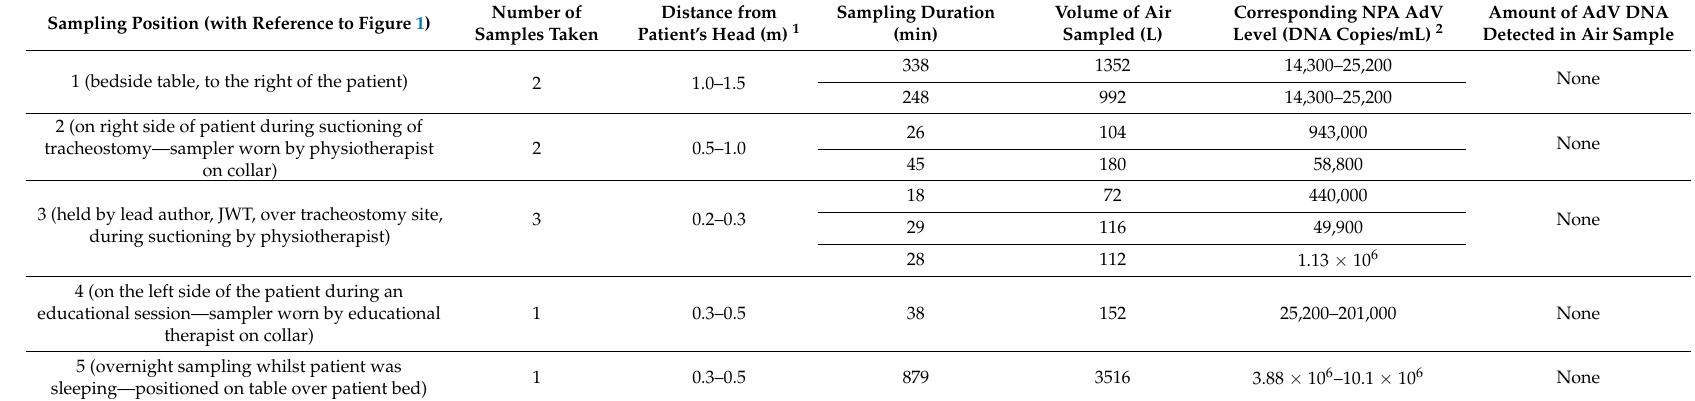
Table 1. Summary of air sampling results. Relative humidity range: 32% to 46%. Temperature range: 23.4 ◦ C to 24.8 ◦